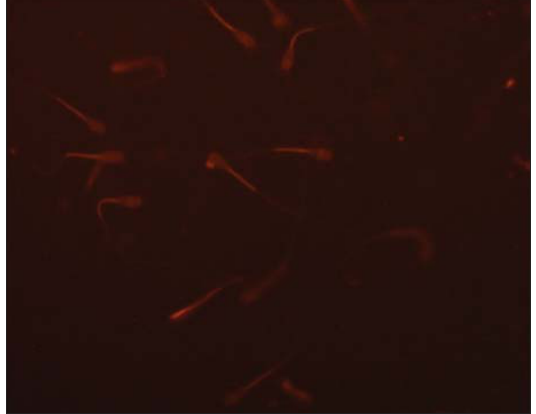
Figure-1: Sperm mitochondria stained with TMRM, TRITC filter (400x).